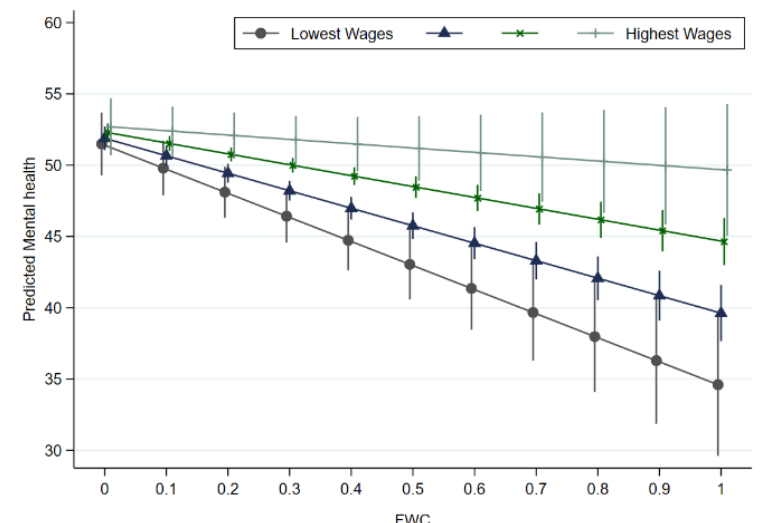
Note: Interaction plot based on linear fixed-effects regressions with interaction terms and predicted margins; p <0.10; N = 4,920. FWC = family-to-work conflicts. Controlled for controlled for age, actual working hours, physical strain, hourly wages, age of youngest child in household. LEEP-B3 Survey, own calculations. Interaction plots for FWC#wages